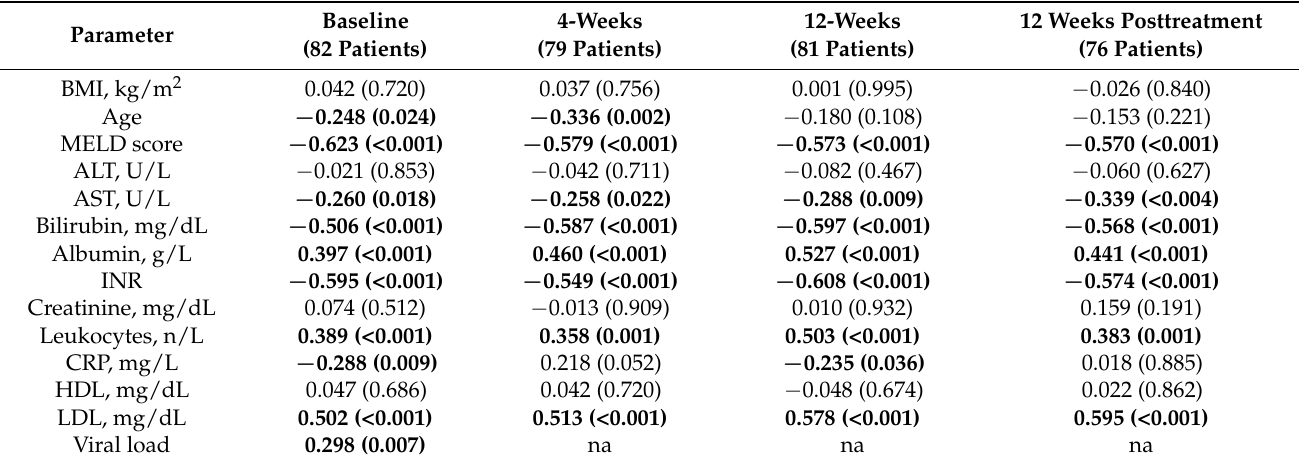
Table 3. Spearman correlation coefficients and p -values for the correlations of PCSK9 with body mass index (BMI), age, model for end-stage liver disease (MELD) score, viral load and routine laboratory parameters in the HCV patients before direct-acting antiviral (DAA) therapy, at 4 and 12 weeks after the start of therapy and 12 weeks